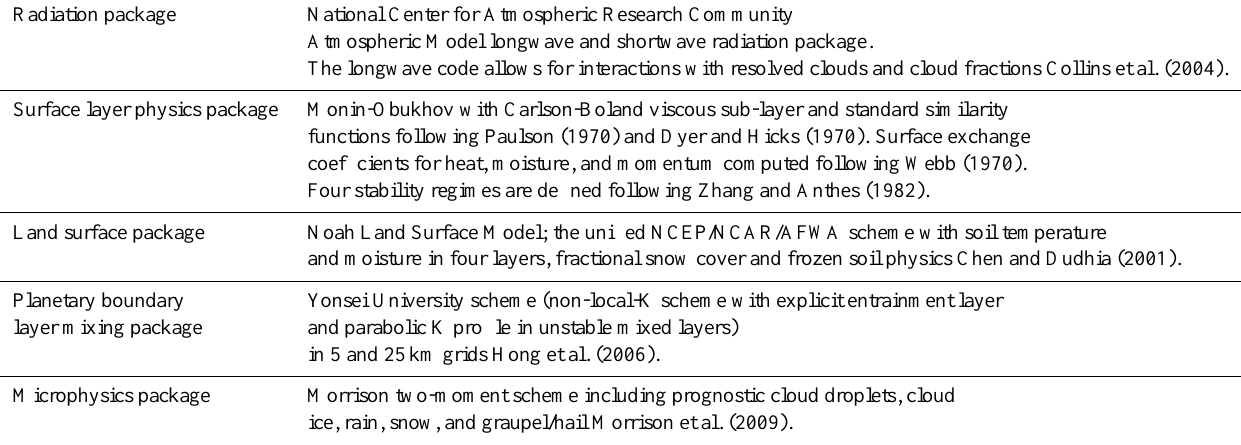
Table 1. Packages used in WRF model setup. Radiation package National Center for Atmospheric Research Community Atmospheric Model longwave and shortwave radiation package. Surface layer physics package Monin-Obukhov with Carlson-Boland viscous sub-layer and standard similarity coefficients for heat, moisture, and momentum computed following Webb